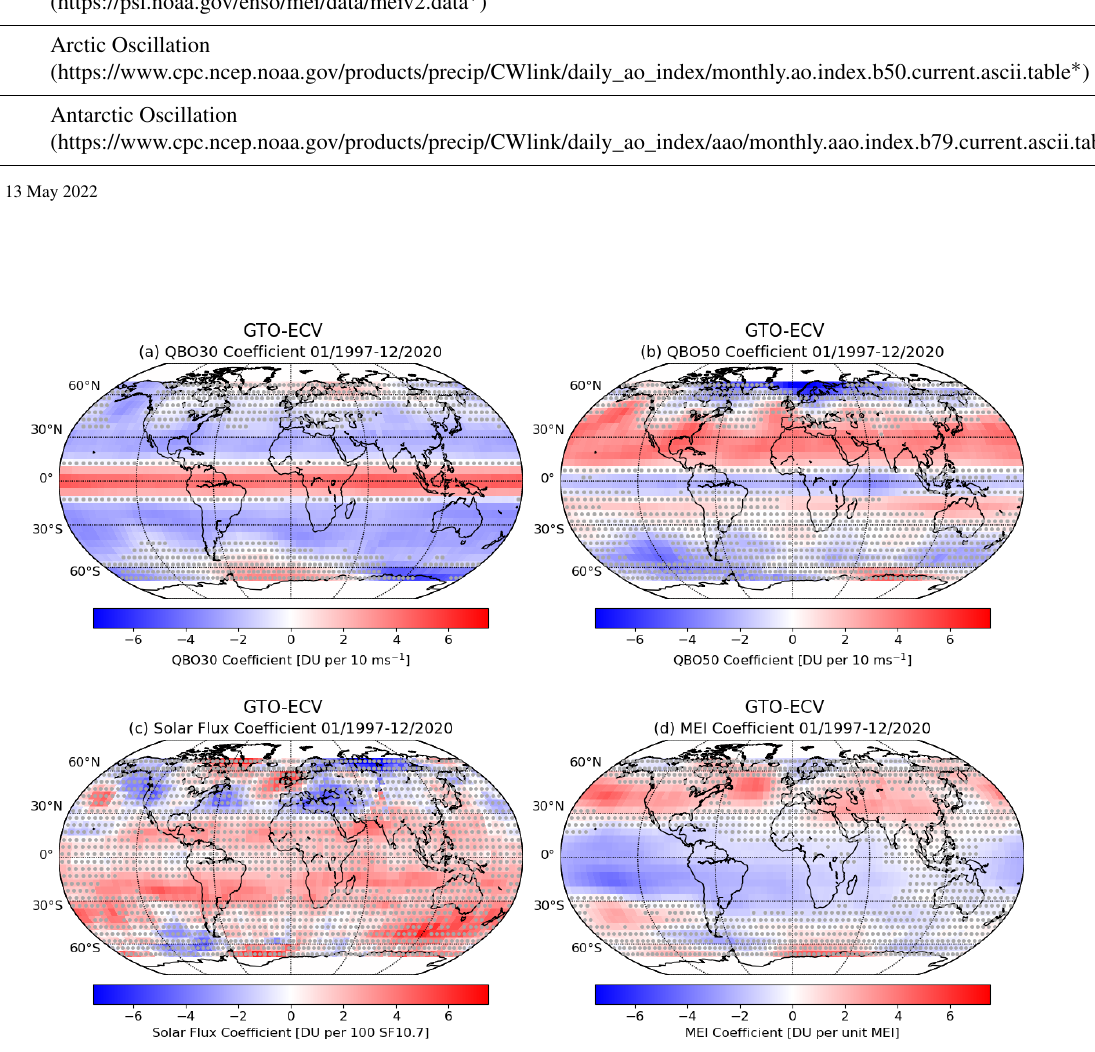
Figure 1. MLR fit coefficients for the explanatory variables (a) QBO at 30hPa (QBO30), (b) QBO at 50hPa (QBO50), (c) solar flux (SF), and (d) multivariate ENSO index (MEI). The results are expressed in Dobson units (DU) per unit of the explanatory variable. Grey dots signify that the term is statistically not significant in this grid